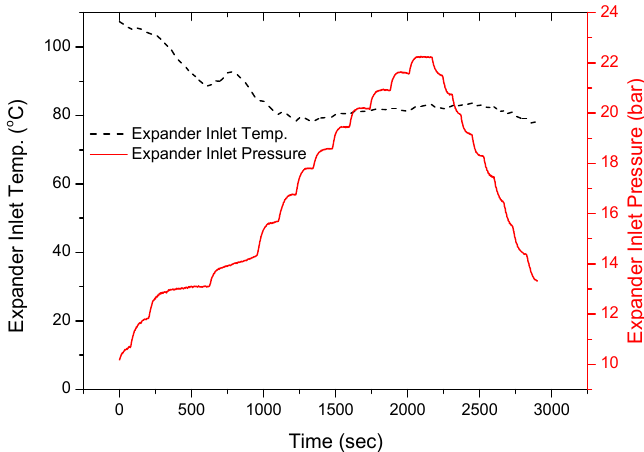
Figure 6. Expander inlet pressure and temperature.